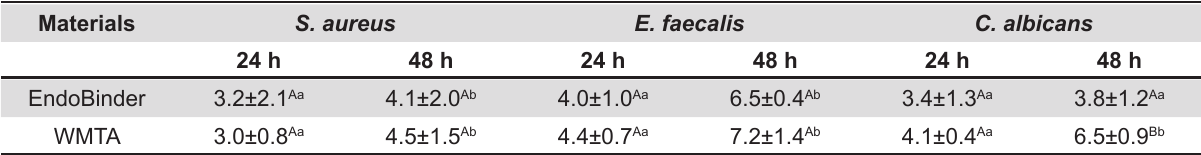
Values are means of microbial growth inhibition (mm) from triplicate experiments. *Different capital letters represent significant differences between the materials in the same experimental time (P<.05). Different lowercase letters represent significant differences between the same material in different time points (P<0.05)